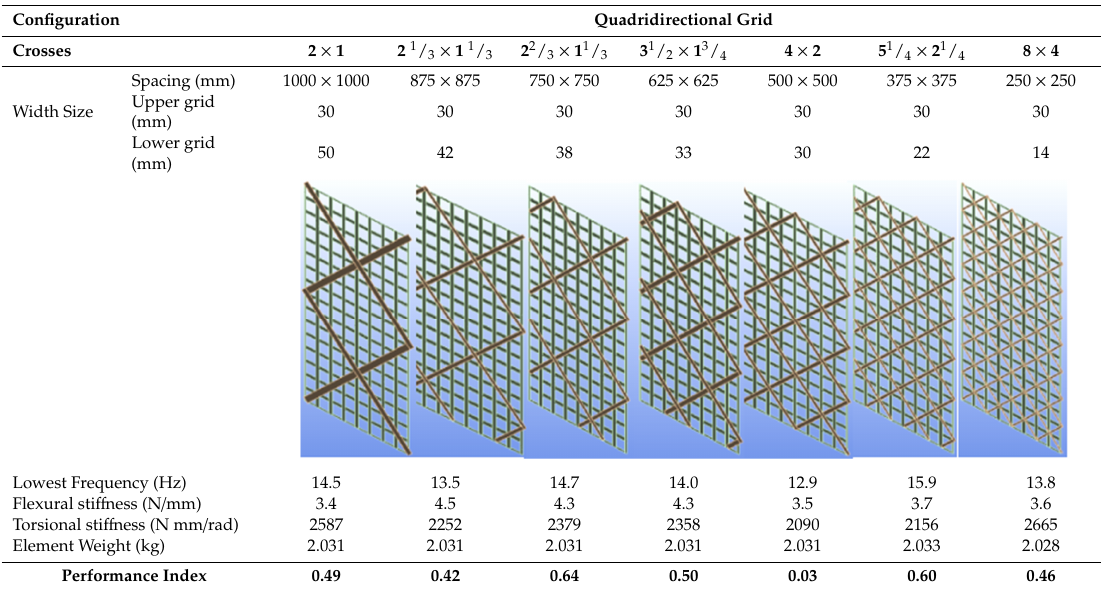
Table 8. E ff ect of changes in grid topology (at the level of mock-up).